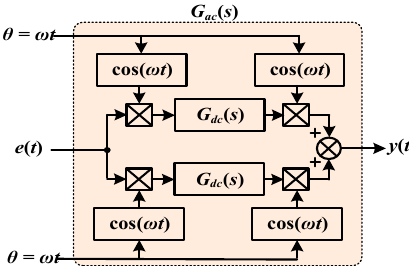
Figure 9. Conversion block diagram of the equivalent transfer function for AC and DC signals.